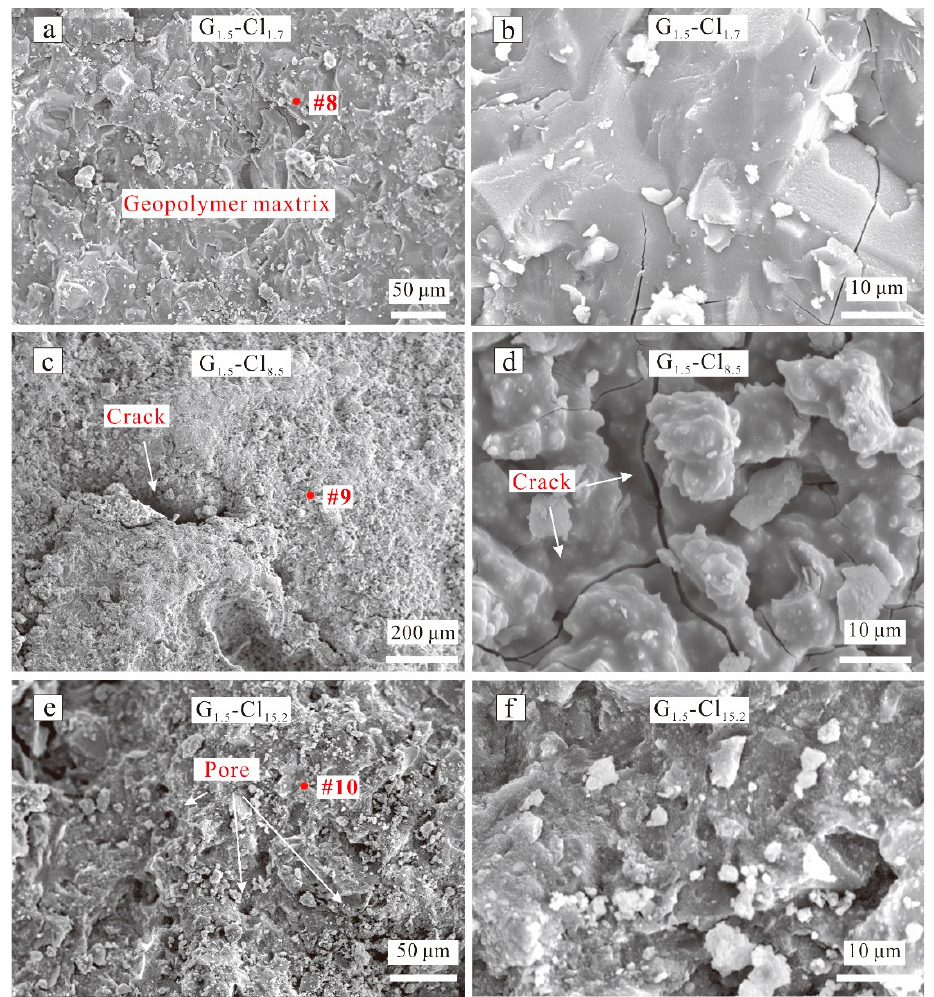
Figure 10. SEM images of Na 2 SiO 4 -activated geopolymers of ( a ) G 1.5 -Cl 1.7 , ( c ) G 1.5 -Cl 8.5 , ( e ) G 1.5 -Cl 15.2 at low magnification; SEM images of Na 2 SiO 4 -activated geopolymers of ( b ) G 1.5 -Cl 1.7 , ( d ) G 1.5 -Cl 8.5 , ( f ) G 1.5 -Cl 15.2 at high magnification.